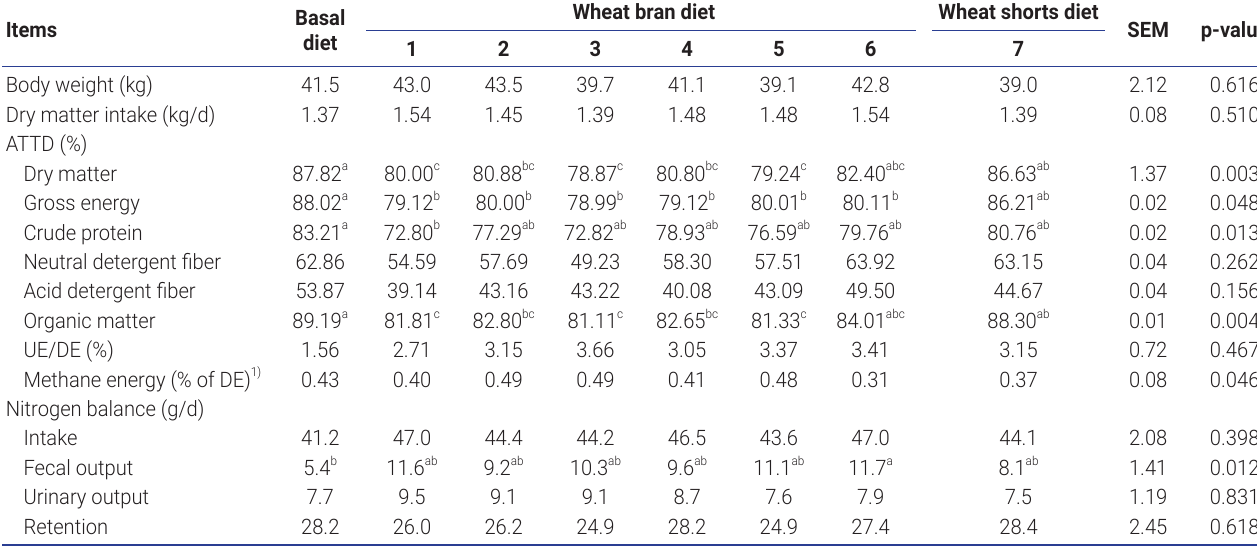
Table 3. Effect of diet characteristics on nutrient digestibility and nitrogen balances of growing pigs fed experimental diets (n = 6) Wheat bran diet Wheat shorts diet Basal Items diet Body weight